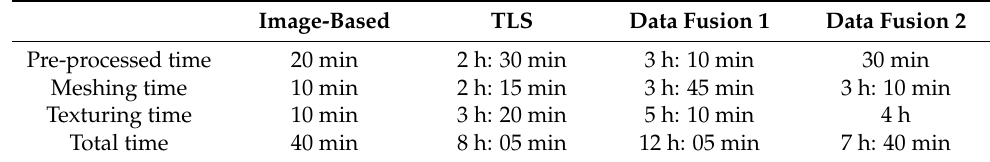
Table 7. Computing times for each model from pre-processed to textured mesh model.